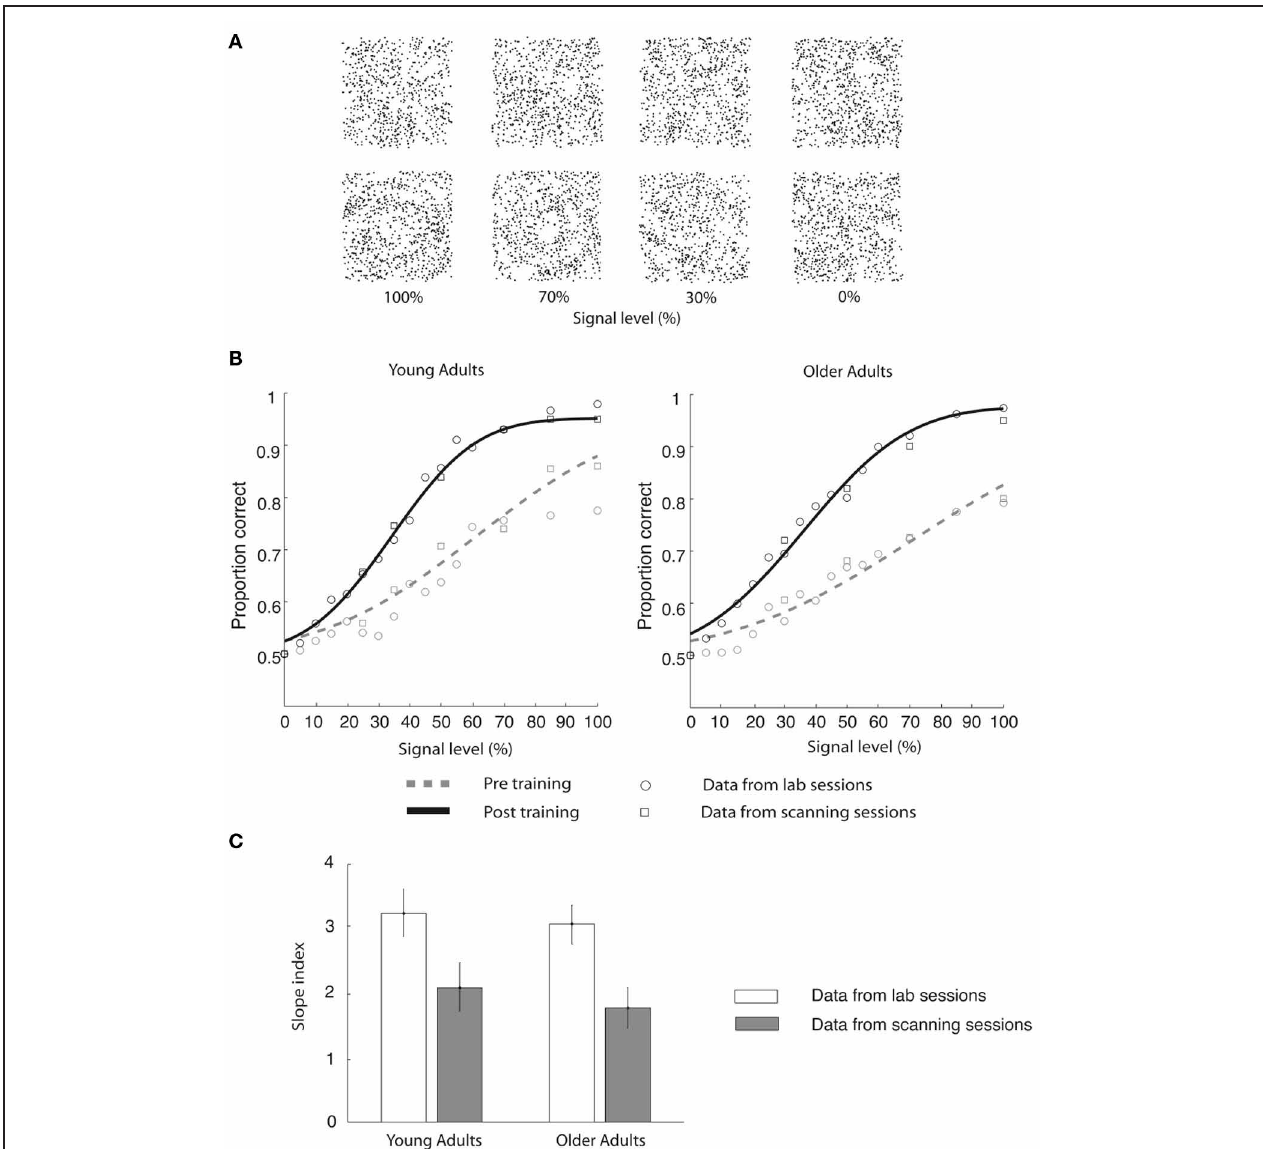
FIGURE 1 | Stimulus and behavioral data. (A) Stimuli: four example Glass pattern stimuli at signal levels of 100, 70, 30, and 0% are shown for the radial category (upper row) and concentric category (lower row), respectively. (B) Behavioral data collected in the lab (circles) and the scanner (squares) are shown for young and older adults for both pre-training (gray dotted line) and post-training (black solid line) sessions. Only the cumulative Gaussian fits of